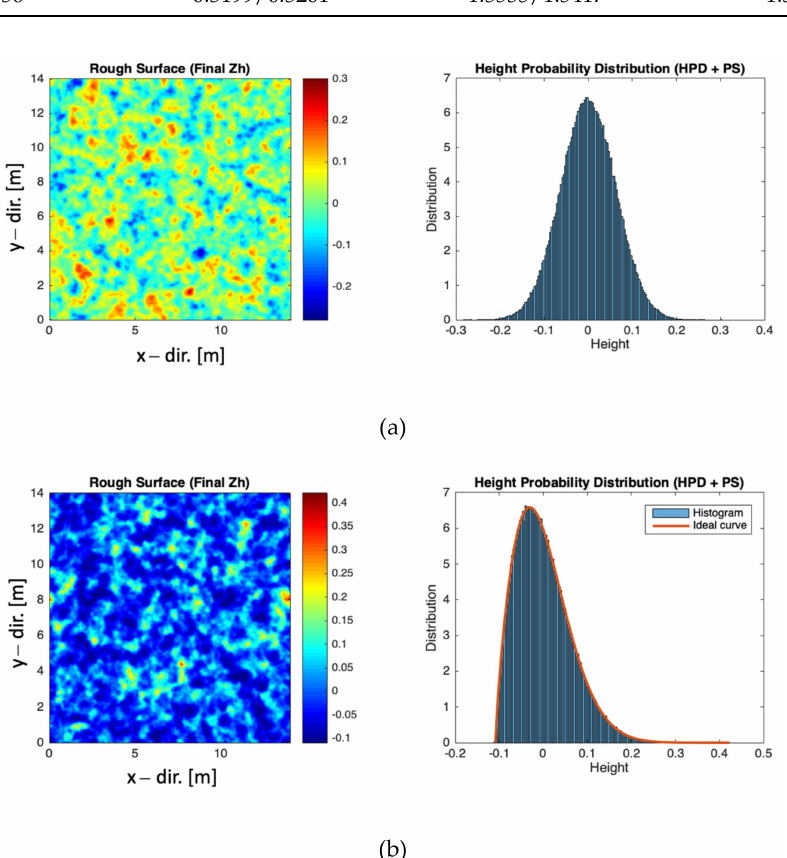
Figure 1. Samples of generated rough surfaces with HPD: ( a ) Gaussian, ( b ) Weibull (shape parame- ter: 1.8). The left panel is sample surface heights, the right panel shows HPDs with red-line denoting the model, and the histogram is the HPD simulated data).